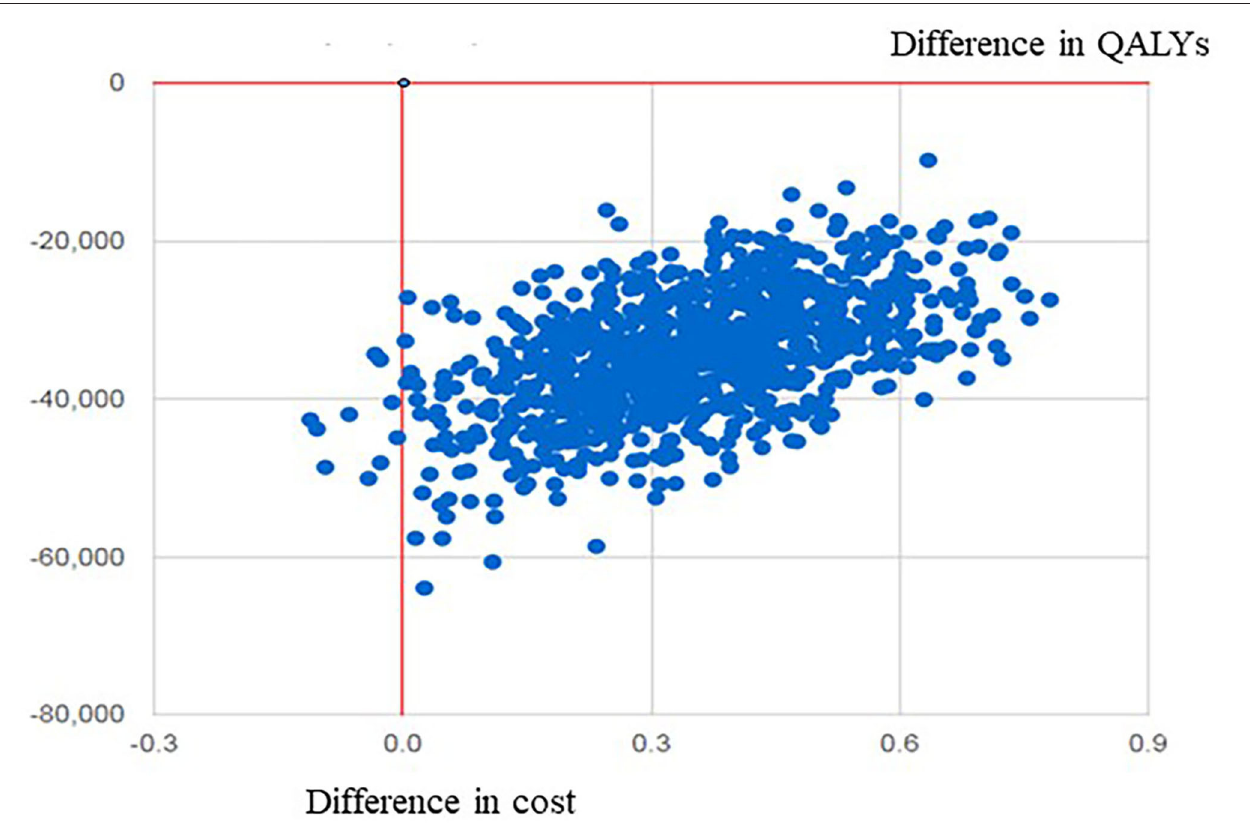
FIGURE 1 | The scatter plot graph of cost-effectiveness of the SSEP compared with routine education. SSEP, self-efficacy-focused structured education program; QALYs, quality-adjusted life-years.